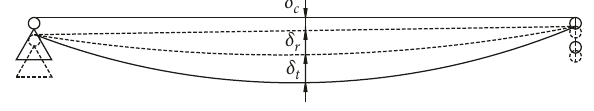
Figure 7: The deflection of the test